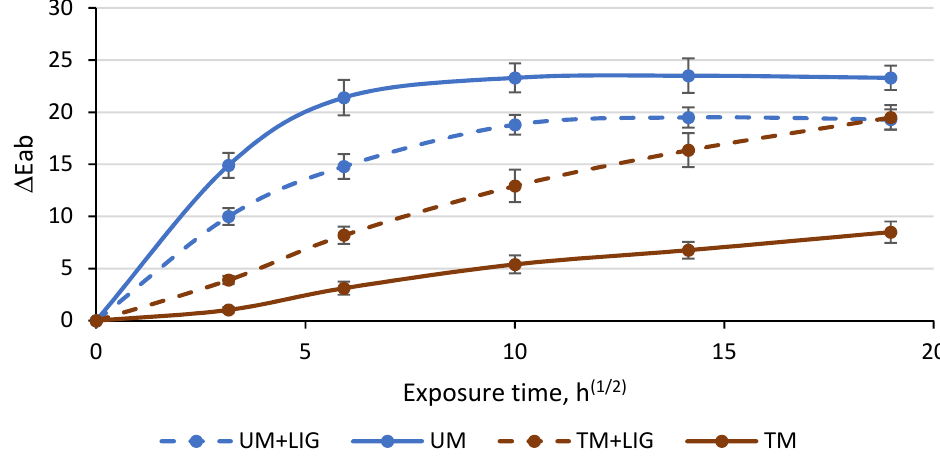
Figure 4. UV radiation caused discoloration of unmodified (UM) and thermally modified (TM) wood with and without pretreatment with wood lignin stabilizing agent (LIG).